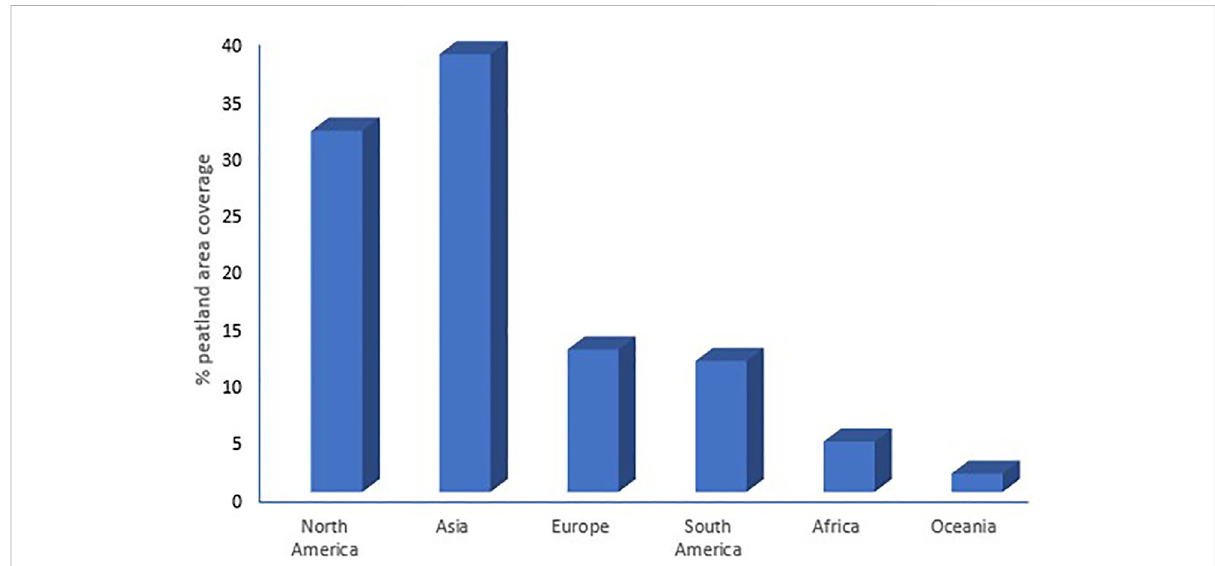
FIGURE 1 Percentage of the world ’ s peatland coverage. Data used was retrieved from PEATMAP (Xu et al., 2018). As a result, 4.23 million km 2 was used as the total global peatland area